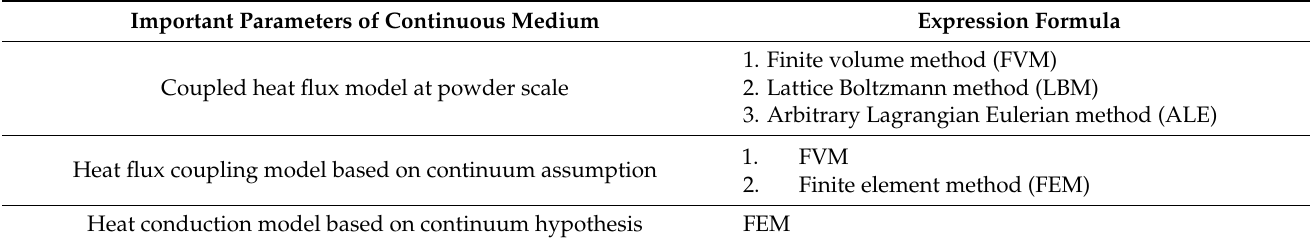
Table 2. Different thermal analysis models and their simulation